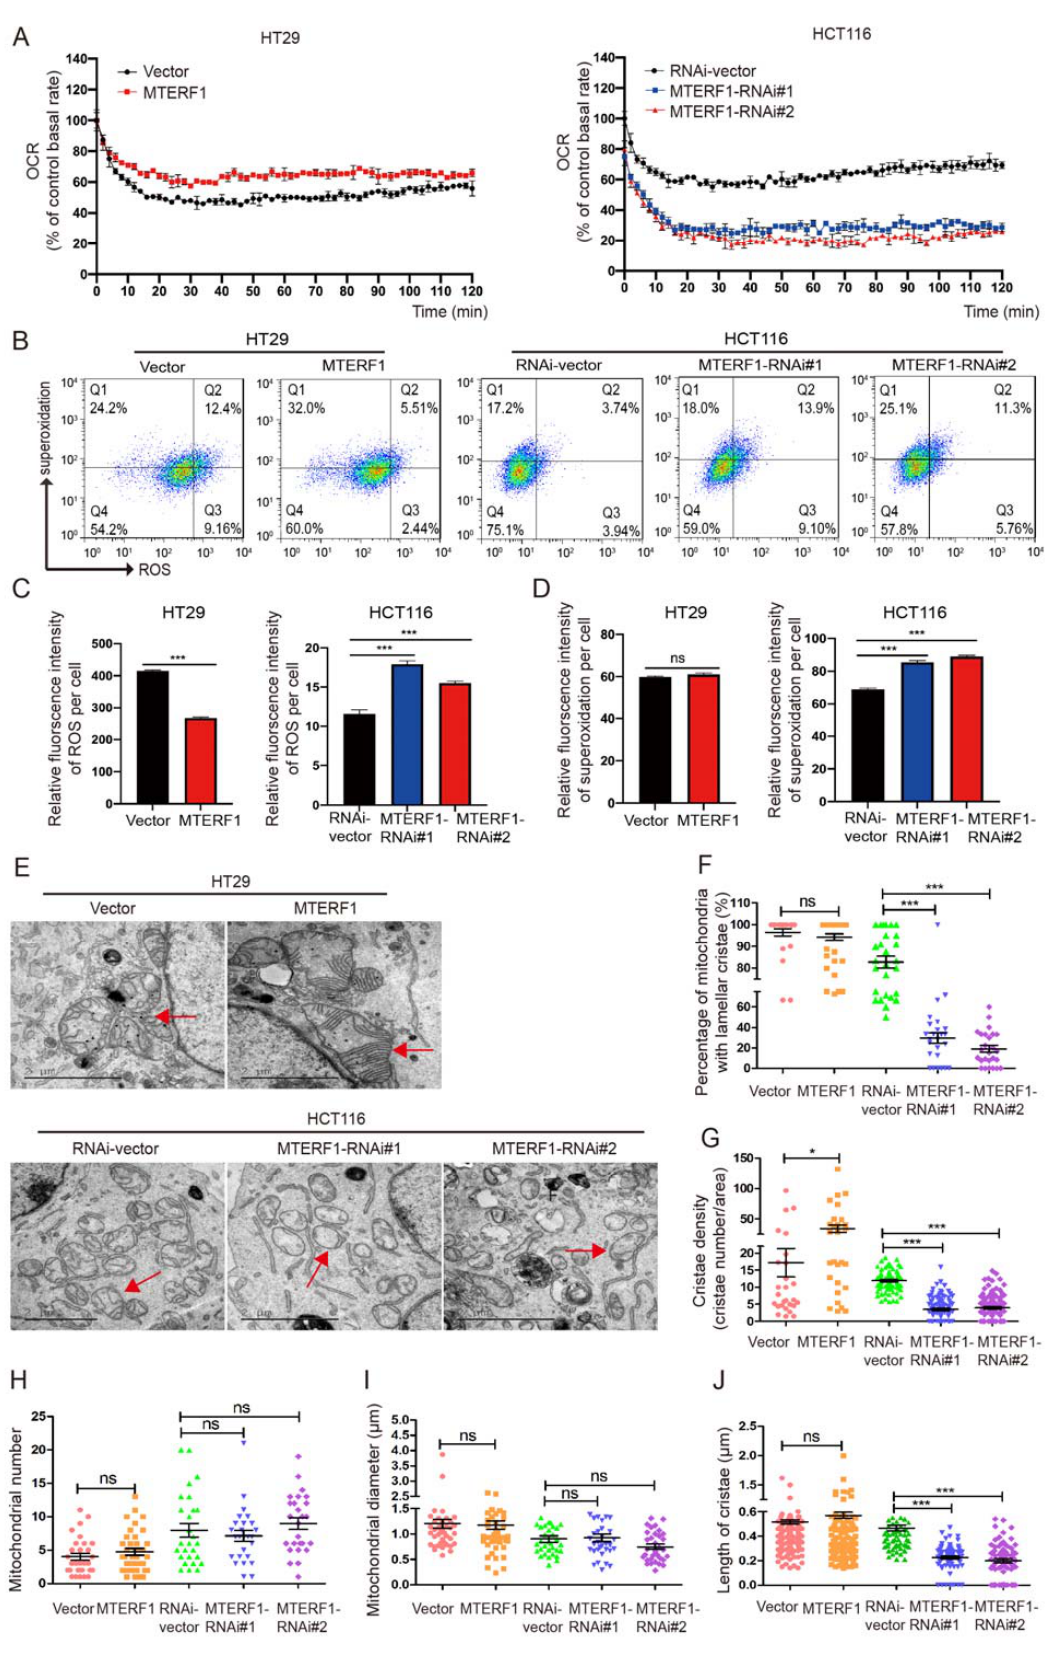
Figure 5. Effect of MTERF1 on the OCR, ROS levels, and mitochondrial inner membrane ultrastructure of colorectal cancer cells. ( A ) OCR detection in CRC cells with MTERF1 overexpression in HT29 cells